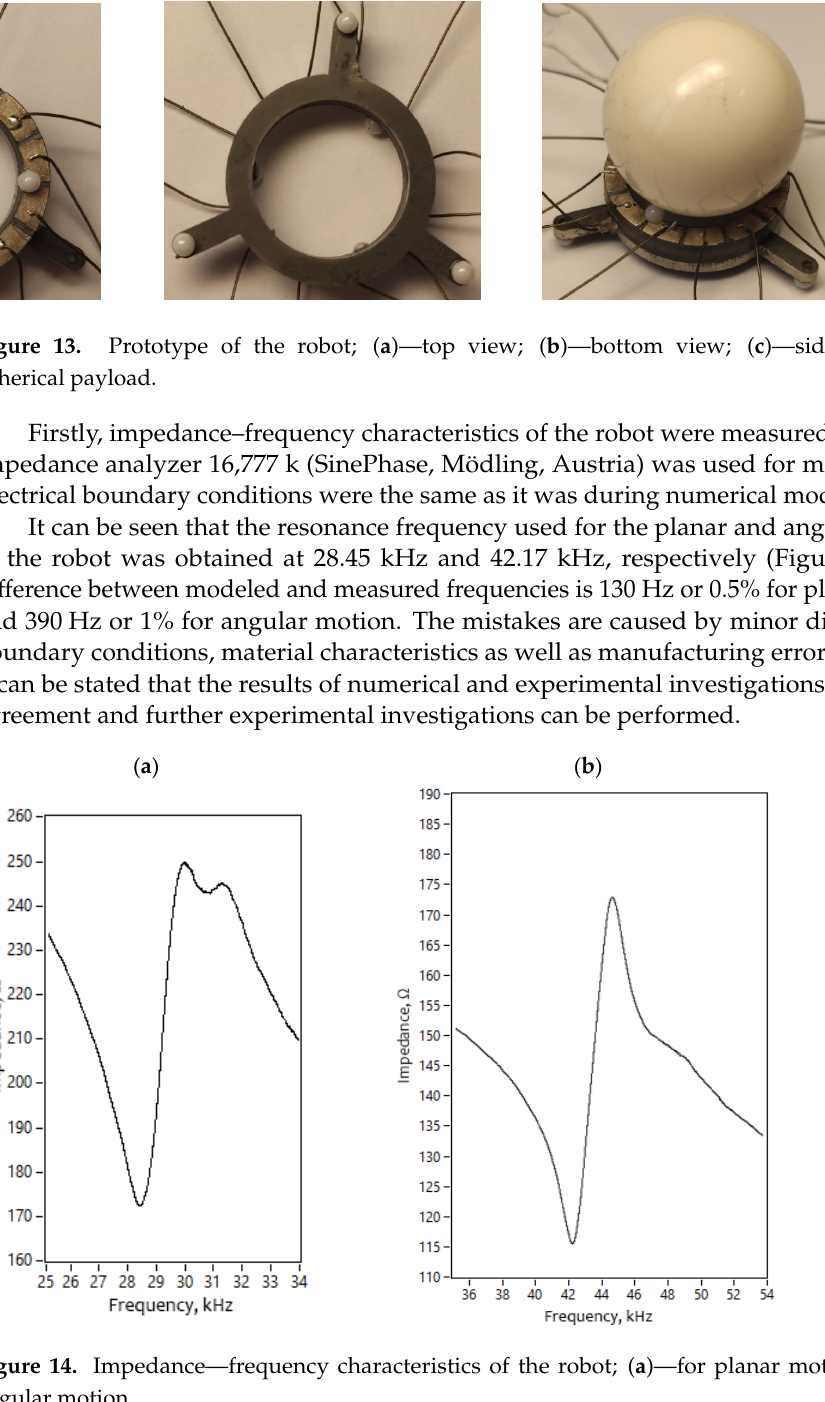
Figure 15. Schematics of the experimental setup; 1—computer; 2—signal generator with two inde- pendent channels; 3—power amplifier; 4—oscilloscope; 5—laser displacement sensor for planar motion measurements; 6— tachometer for angular motion measurements; 7—switch box for planar motion control; 8—switch box for angular motion control; 9—the prototype of robot. The experimental setup included a computer, a function generator WW5064 (Tabor Electronics, Nesher, Israel), a power amplifier PD200X4 (Piezo Drive, Shortland, Aus- tralia), an oscilloscope DL2000 (Yokogawa, Tokyo, Japan), a displacement sensor ILD 2300